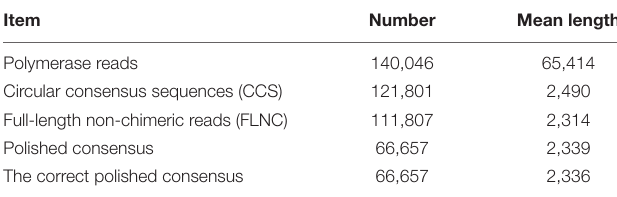
TABLE 1 | Summary of reads from third-generation long-read sequencing.